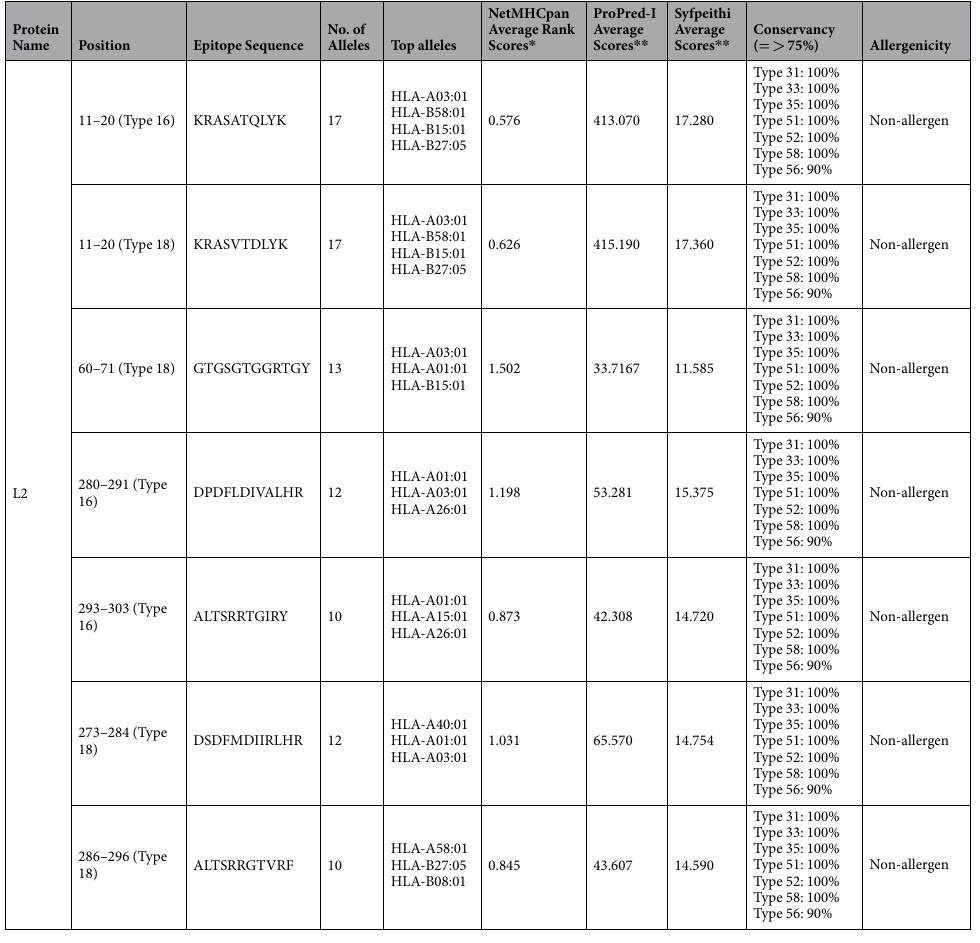
Table 5. The selected CTL epitopes of HPV L2 Protein, based on binding affinity. * lower rates show better binding affinity, ** Higher rates show better binding